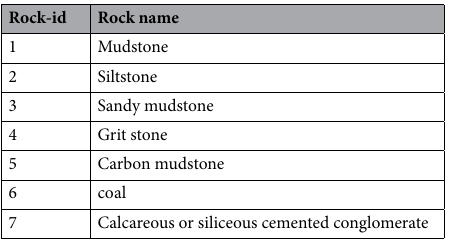
Table 4. Lithology